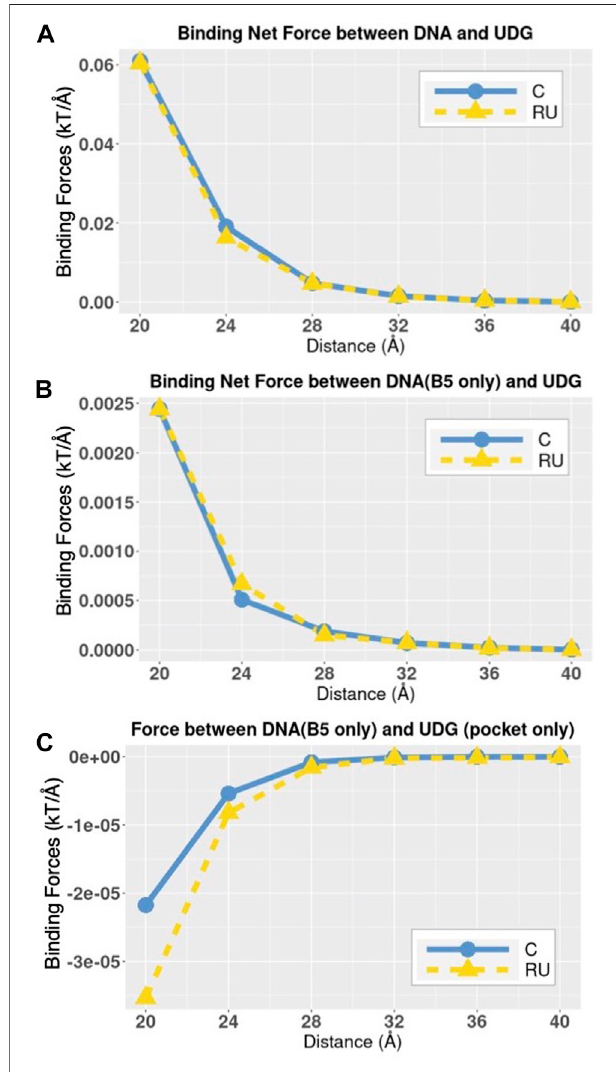
FIGURE 8 | The trends of total electrostatic forces between DNAs and UDG. (A) Electrostatic-bindingnetforcesbetweenDNAandUDGatdistances from20 Åto40 Åwiththestepsizeof4 Å. (B) Electrostatic-bindingnetforces between DNA (B5 base only) and UDG at distances from 20 Å to 40 Å withthestepsizeof4 Å;inDNA_RUtheB5baseisuracilandinDNA_CtheB5 base is cytosine. (C) Electrostatic-binding net forces between DNA (B5 base only) and the UDG pocket at distances from 20 Å to 40 Å with the step size of 4 Å; in DNA_RU the B5 base is uracil and in DNA_C the B5 base is cytosine.